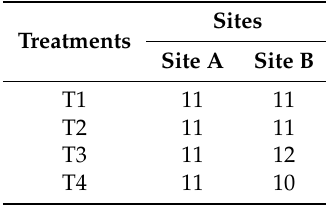
Table 2. Number of replicates per analysed unit. T1 to T4 are different tillage treatments (not in the focus of this study, hence not